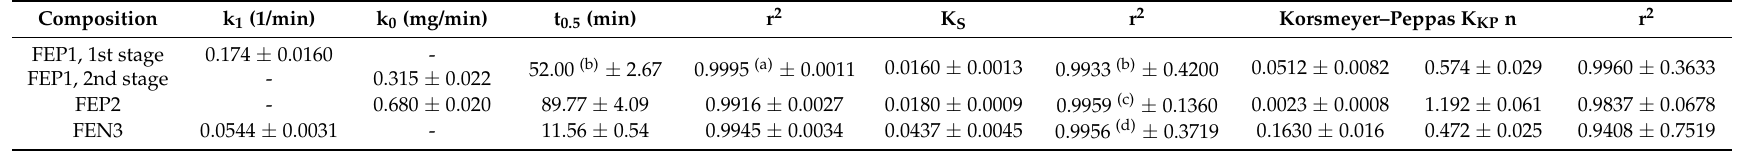
Table 3. Basic kinetic parameters of the process of API kinetics release from the tested preparations: FEP1, FEP2, and FEN3.